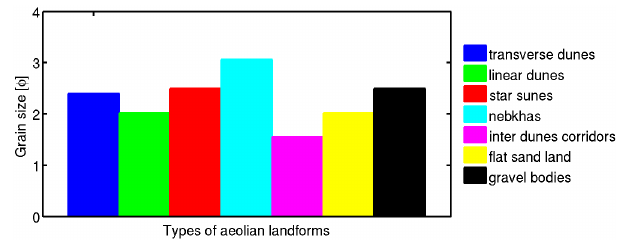
Figure 3 Distribution of sand grains in the Kumtagh Desert Fig. 3. Distribution of sand grains in the Kumtagh